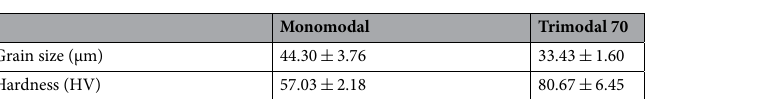
Table 4. Measurement results of average grain size and Vickers hardness of the 70 vol.% sintered part using monomodal vs. trimodal powder (grain size was determined using ImageJ analysis and hardness measurement was done on 10 different spots for each